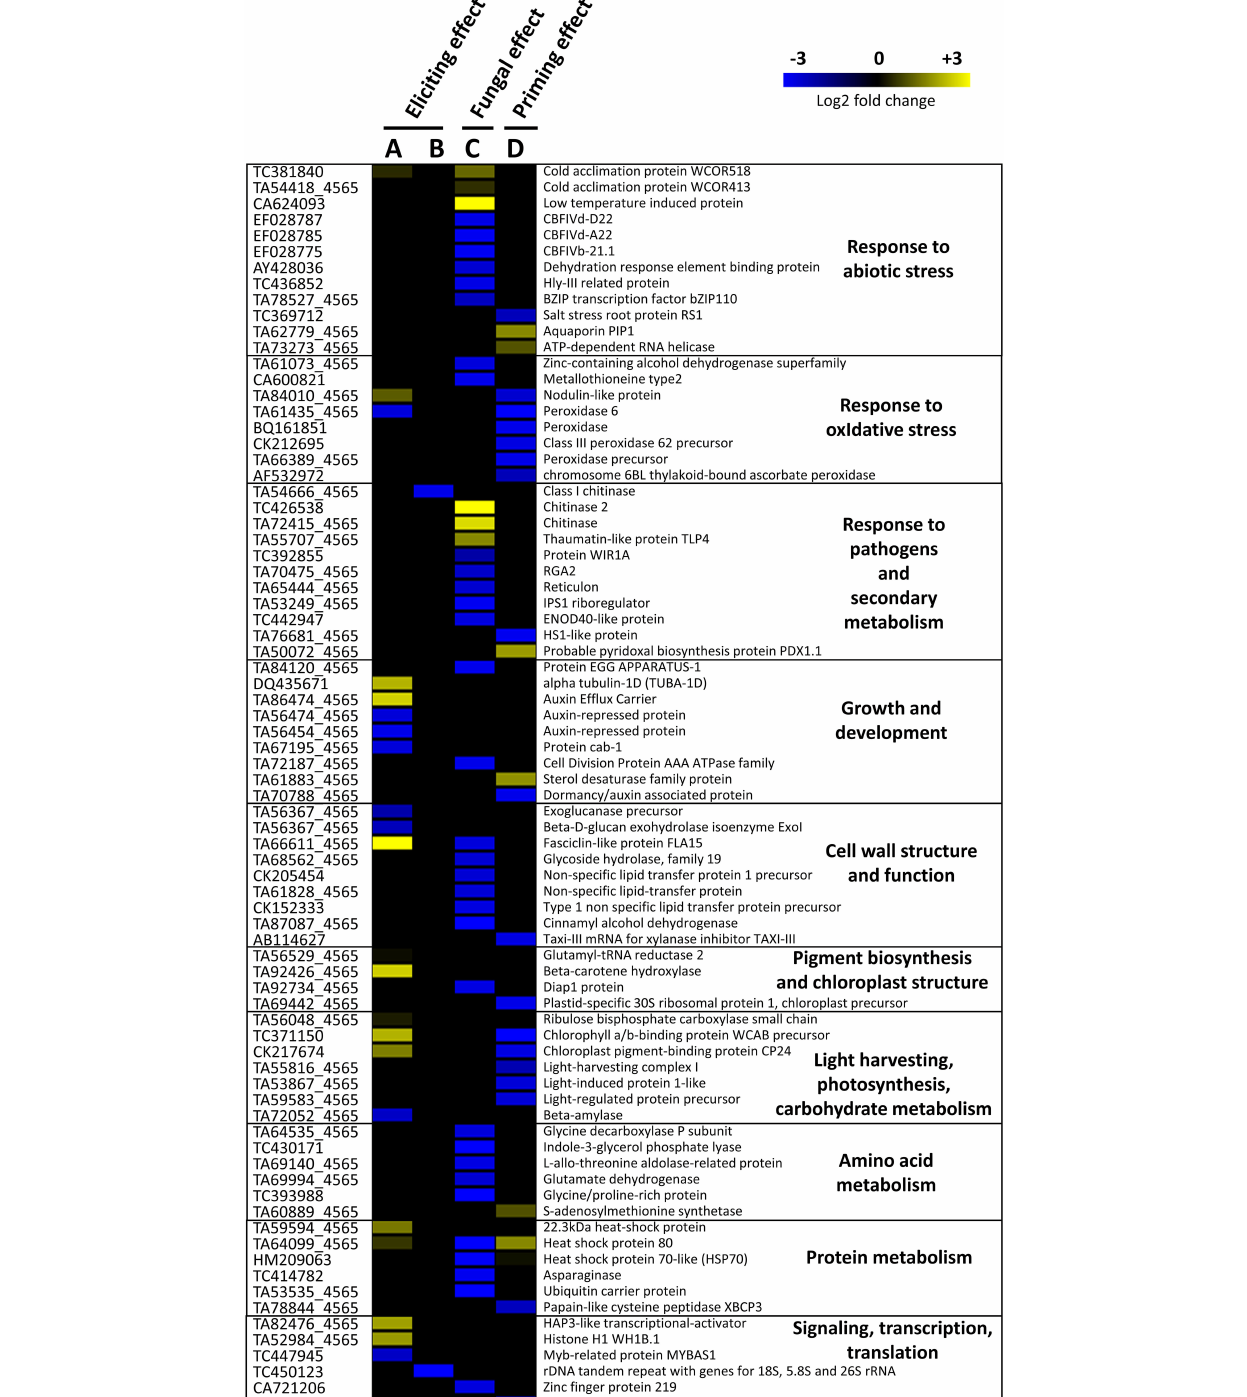
Frontiers in Plant Science |